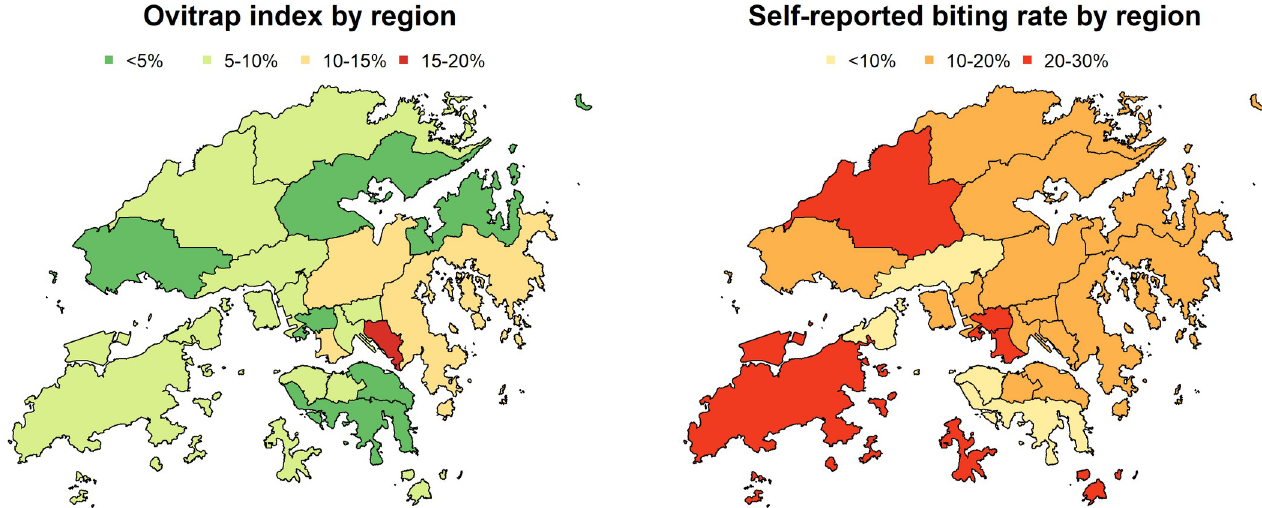
Fig 4. Maps of ovitrap index and self-reported biting rate in August 2018. Source: Based on the data from Hong Kong SAR Government Planning Department, 2016 Tertiary Planning Unit and Street Block/Village Cluster (TPU&SB/VC) Boundaries.